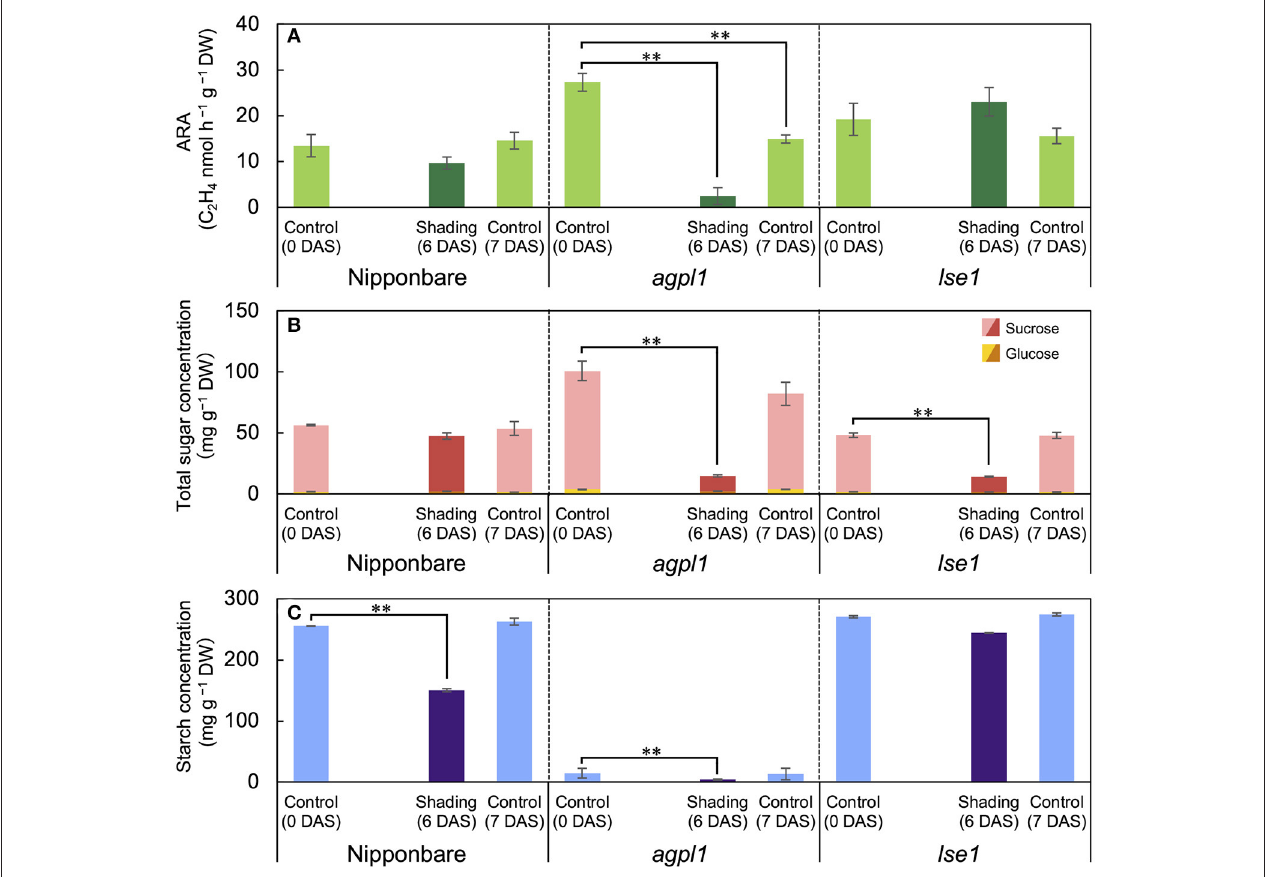
FIGURE 3 | The acetylene reduction activity (ARA) (A) , total sugar (sucrose and glucose) concentration (B) , and starch concentration (C) in stem of rice genotypes at shading experiment. DAS indicates days after shading. Data are means ± SE ( n = 4). **indicate significance at P = 0.01 level assessed by Dunnett’s test. In the Dunnett’s test, values of 0 DAS served as control. Sugars were tested at the total sugar concentration of sucrose and glucose.